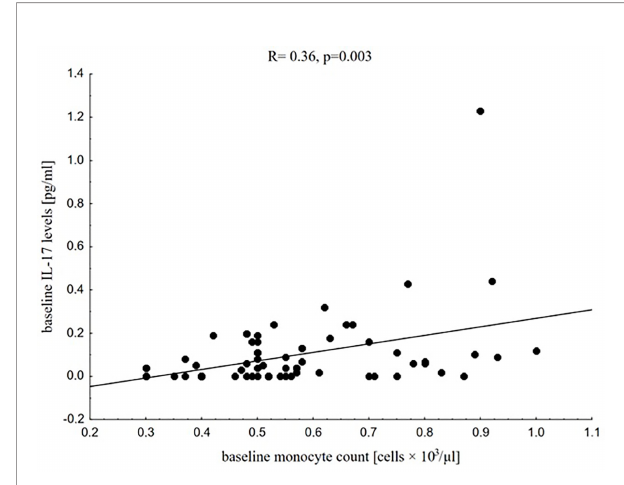
FIGURE 2 | Distribution of vitamin D values in the subgroup with severe 25 (OH)D de fi ciency and CRP <=